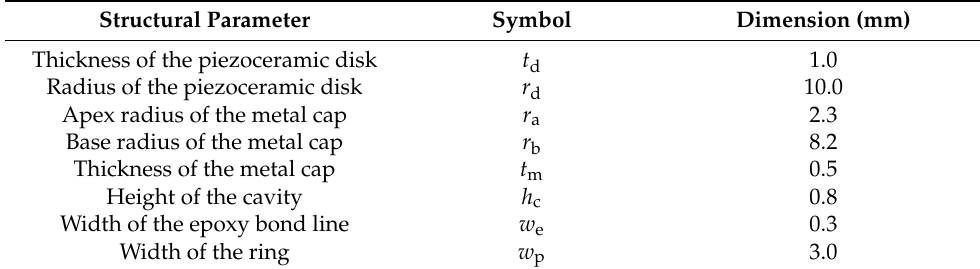
Table 1. Dimensions of structural parameters of the cymbal transducer.